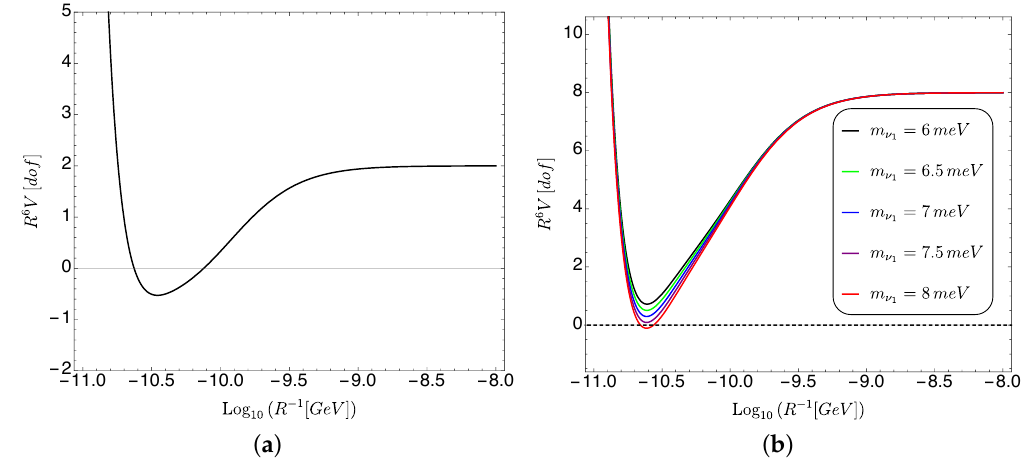
Figure 5. Figures taken from [98]. The vertical axis represents the 3d effective potential for the radion, V ( R ) (in units of with r = 1GeV), multiplied times R 6 so as to give a constant profile when R → 0, and it is normalized by the contribution of one degree of freedom ( a ) Radion effective potential for Majorana neutrinos (with heavy Majorana masses) where an AdS minimum always develops. ( b ) Radion effective potential for (pseudo-)Dirac neutrinos with different values for the lightest neutrino mass m ν (in mili-electron volts). The formation of an AdS vacuum can be avoided if the neutrino masses are light 1